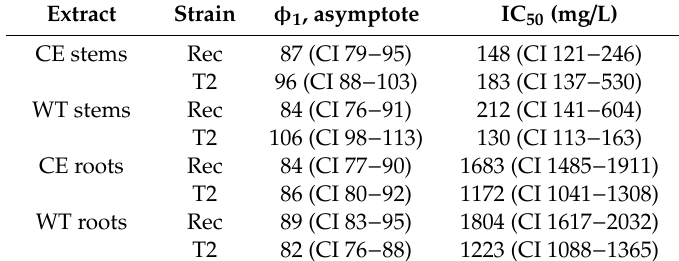
Table 4. Estimated IC 50 values of polyphenolic extracts with 95% confidence intervals (CI) from hop roots and stems against V. nonalfalfae in vitro growth.